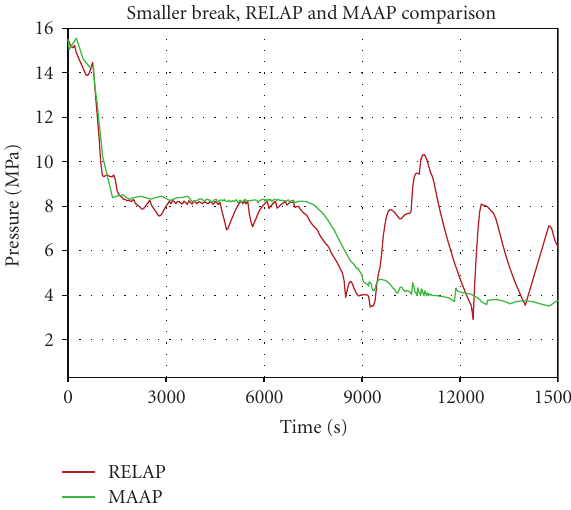
Figure 5: Collapsed water level in the reactor vessel, MAAP4 calculation, Group 1.